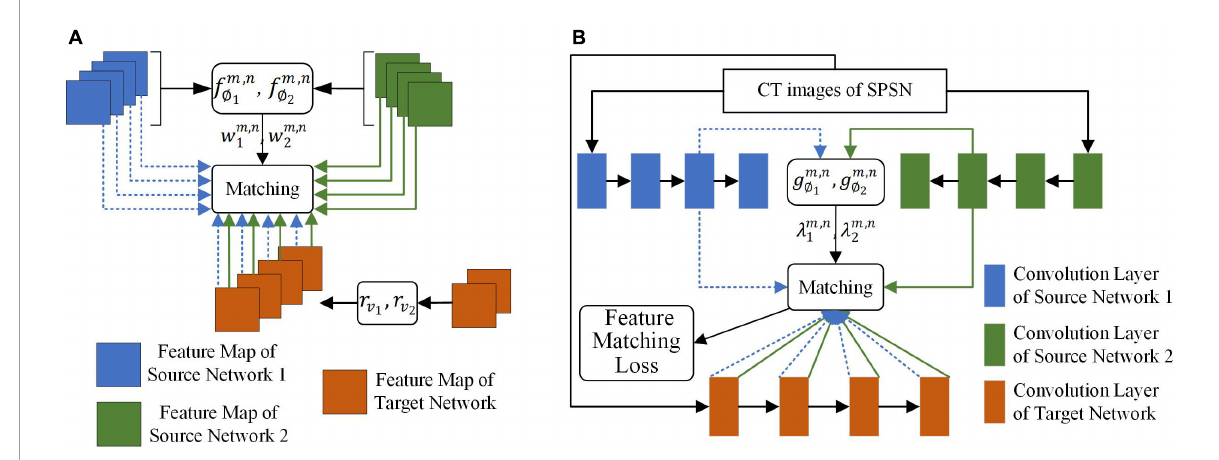
FIGURE3 The adaptive selection-based dual-source domain feature matching network for selective knowledge transfer. (A) Matching of the feature map between the source networks and the target network. (B) Matching of the feature map of the convolution layer between the source networks and the target